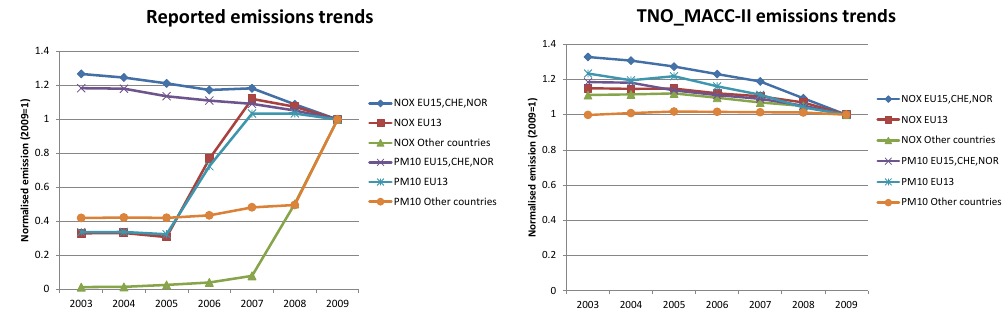
Figure 2. Trends in reported emissions (left panel) and TNO_MACC-II (right panel) normalized to 2009 = 1.